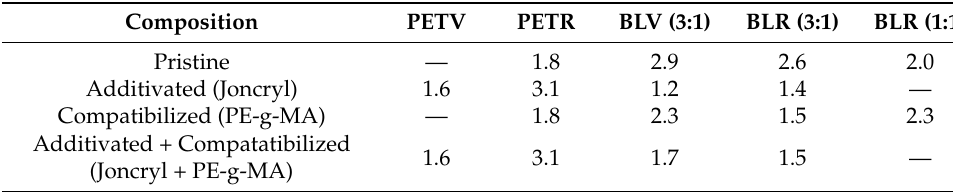
Table 2. Parameter: R M